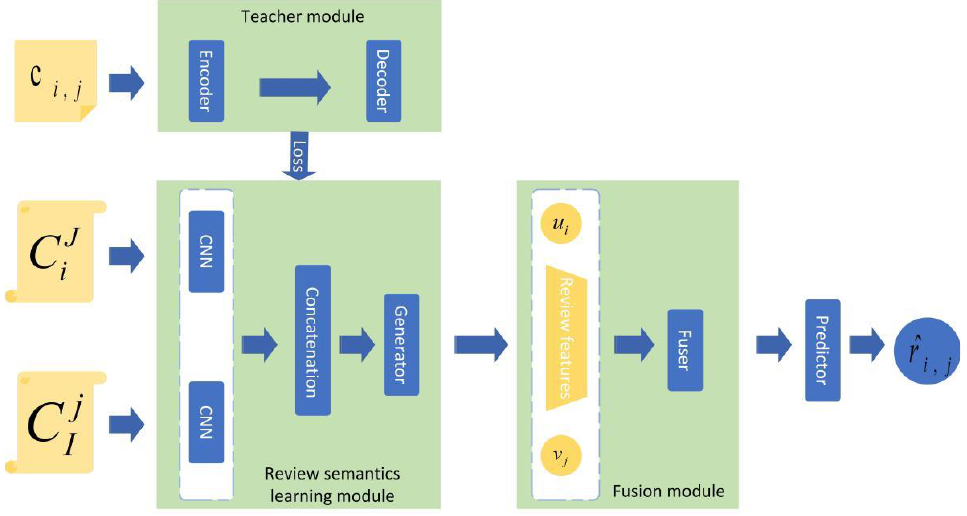
Figure 3. The framework of the RSII model.